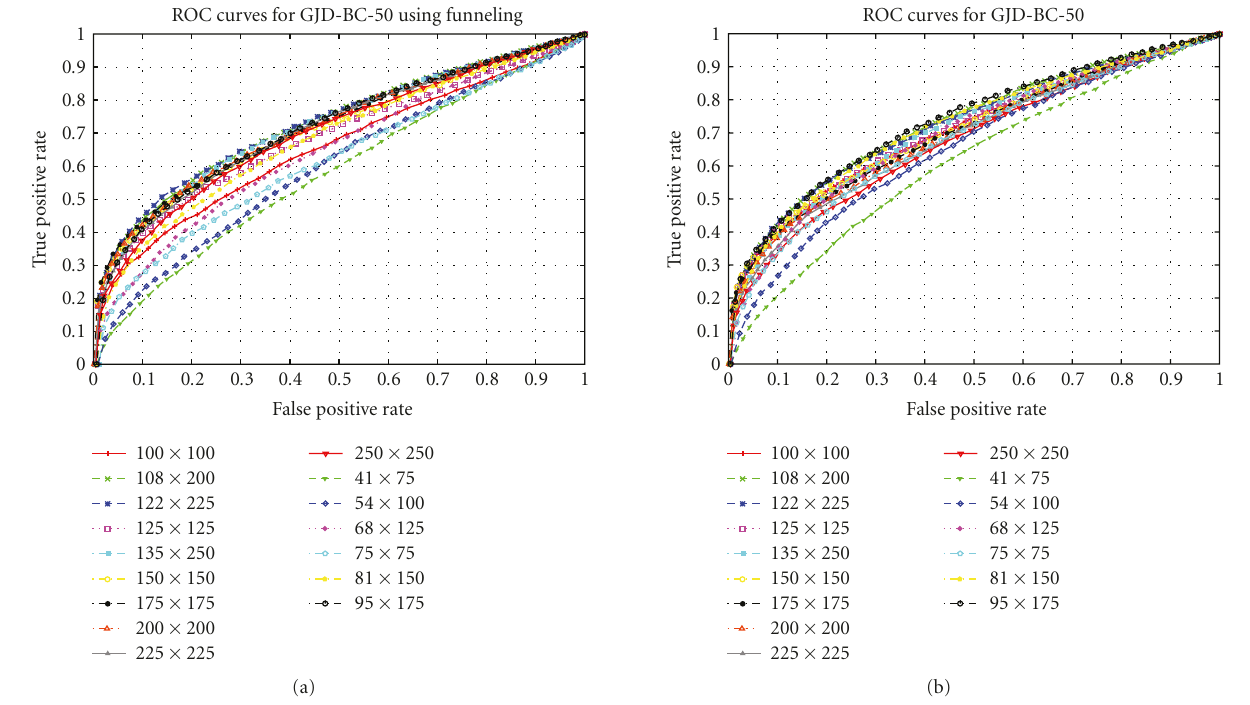
Figure 6: E ff ect of the image’s region size on the performance of the GJD-BC-50 method. (a) Faces aligned using funneling; (b) unaligned faces.